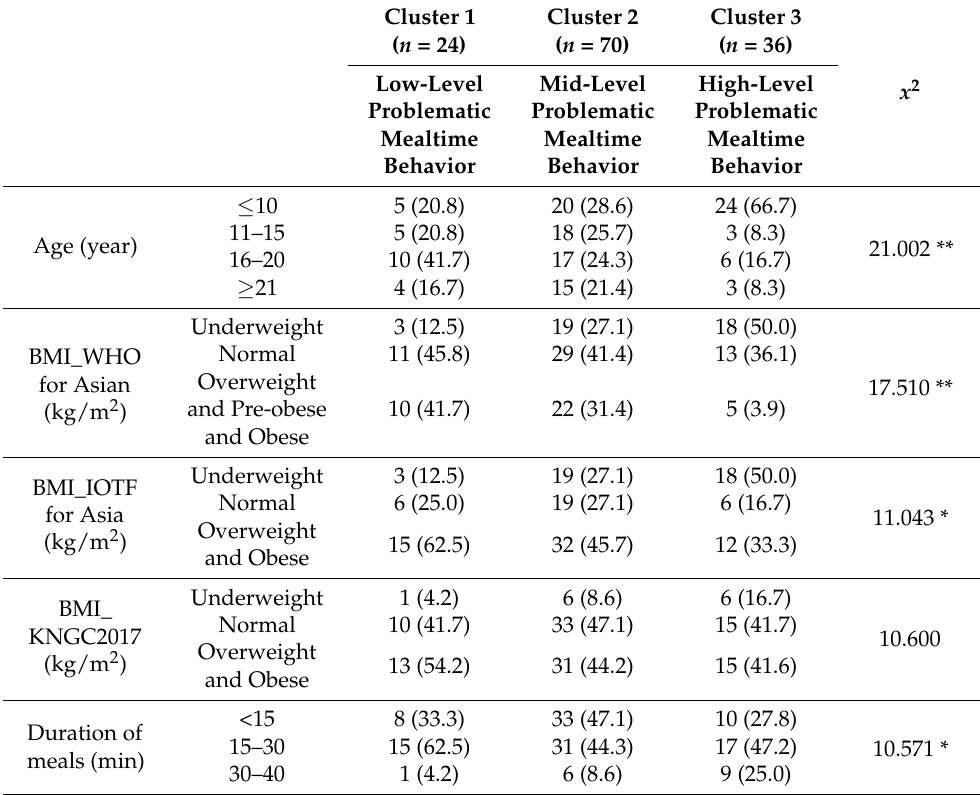
Table 6. Demographic profile of ASD students’ mealtime behavior